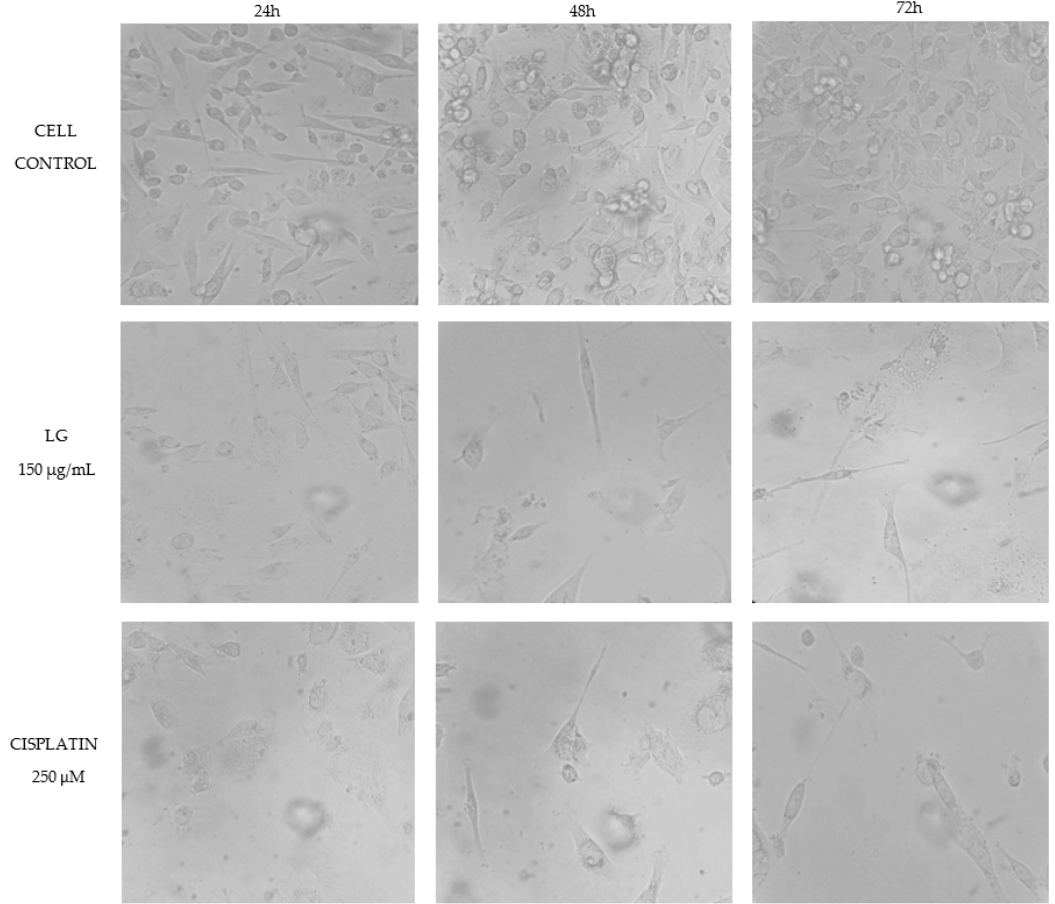
Figure 4. MDA-MB-231 cells exposed to different treatments during three incubation times (24, 48, and 72 h). Cell control represents cells without treatment. Images obtained under the microscope (40×).